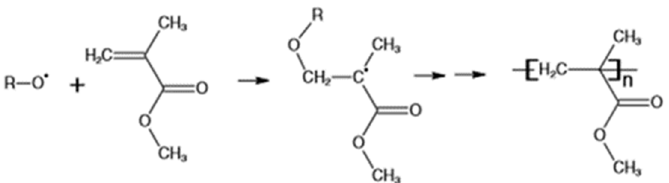
Figure 2. Radical polymerization of Elium matrix to form high-molecular-weight acrylic co-poly- mers with the addition of a benzoyl peroxide initiator [2,5,31].